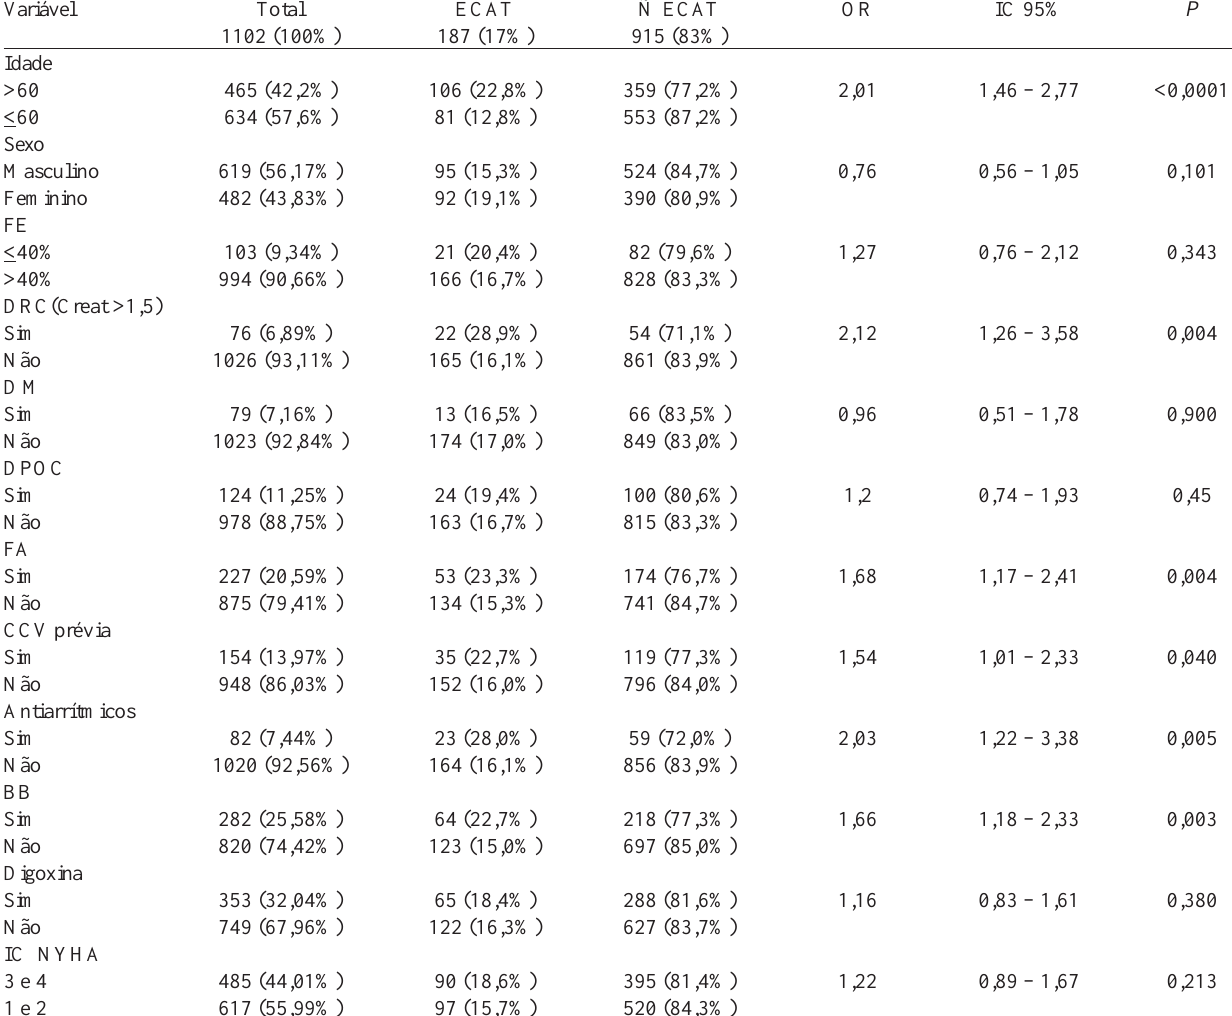
Tabela 1. Características pré operatórias dos grupos e análise